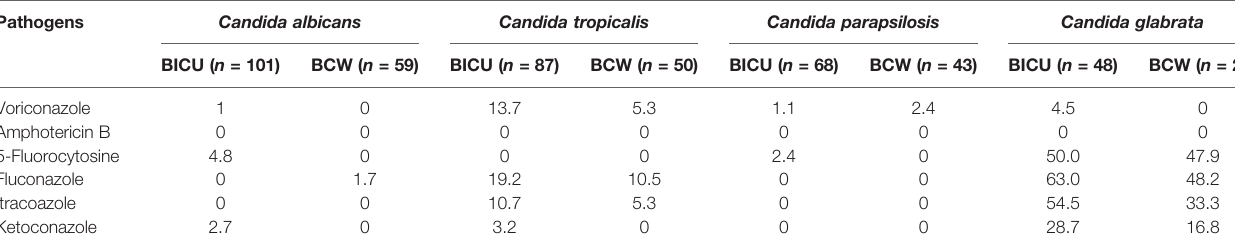
TABLE 5 | The resistance of common fungi to antifungal drugs.